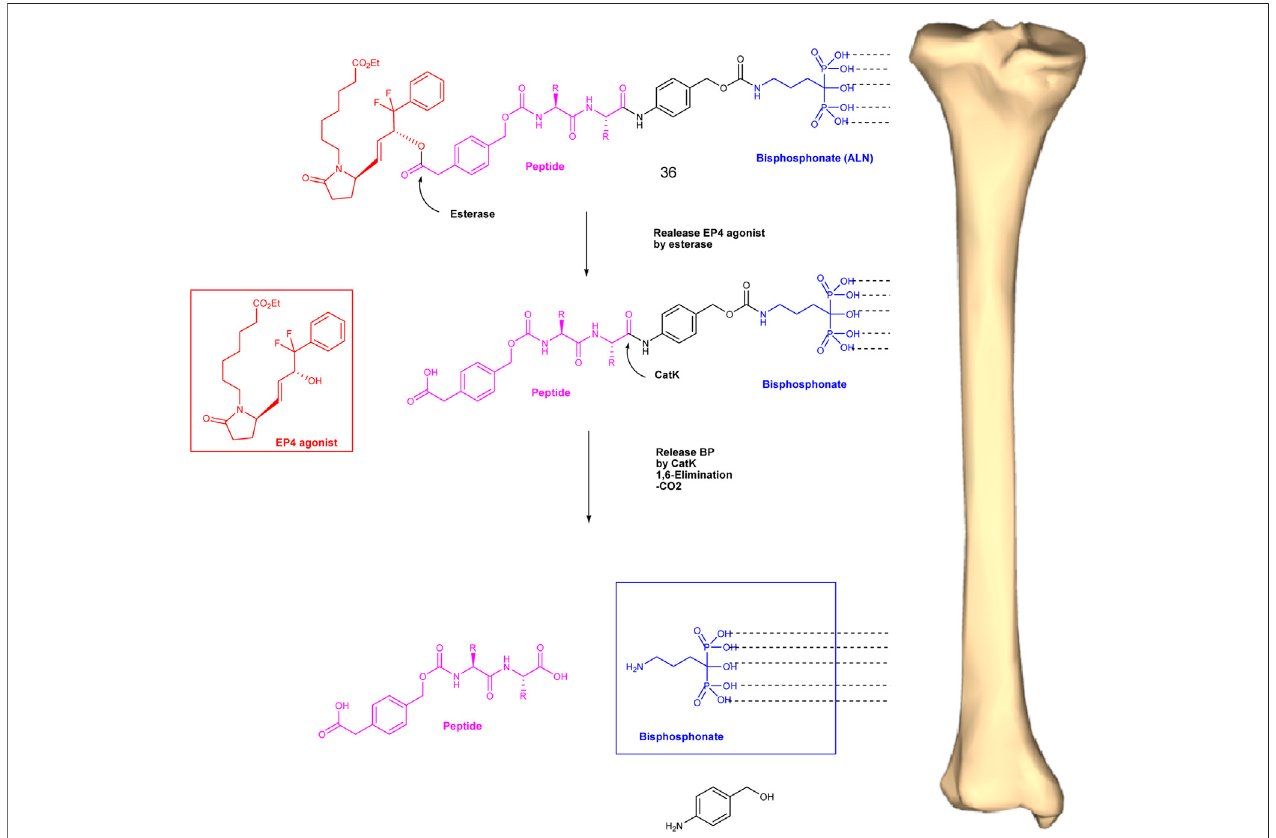
FIGURE 7 | Conceptual differential enzymatic release of active EP4 agonist and bound bisphosphonate from the conjugate after binding to the bone surface.